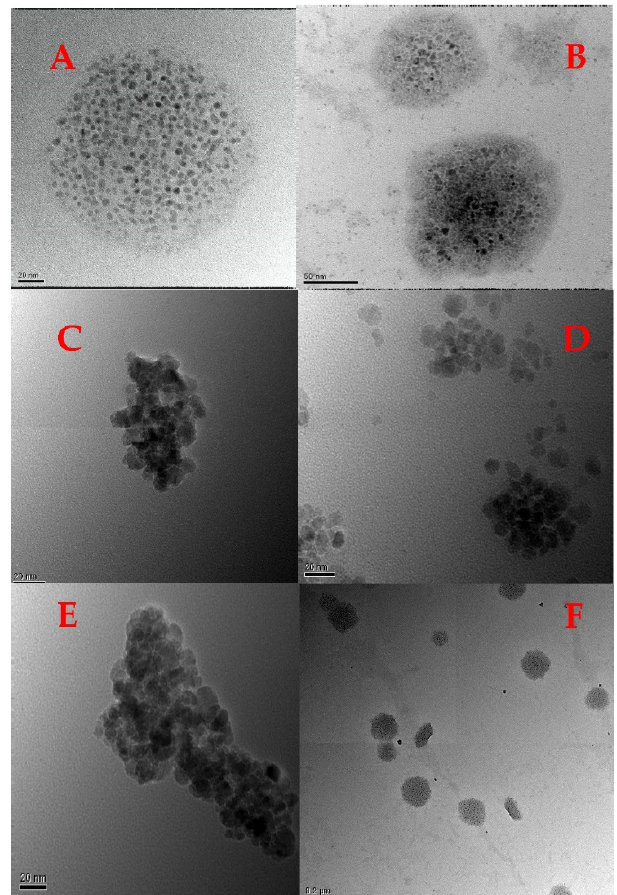
Figure 3. TEM images of SPION1 ( A , B ), SPION3 ( C , D ), and SPION4 ( E , F ).